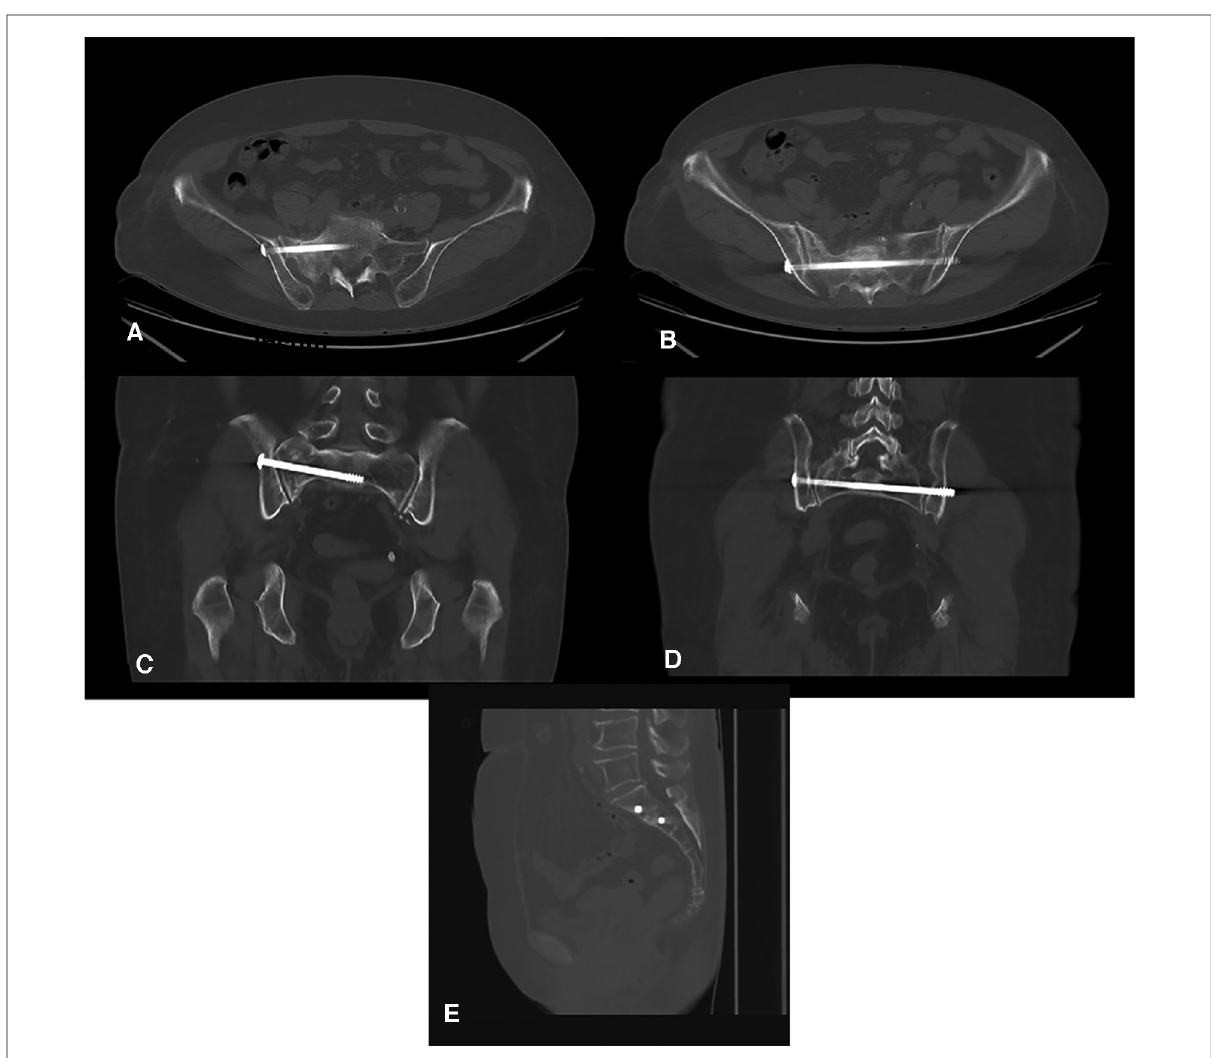
FIGURE 8 Imaging veri fi cation with rail-bound CT during operation. ( A,B ) Horizontal view. ( C,D ) Coronal view. ( E ) Sagittal